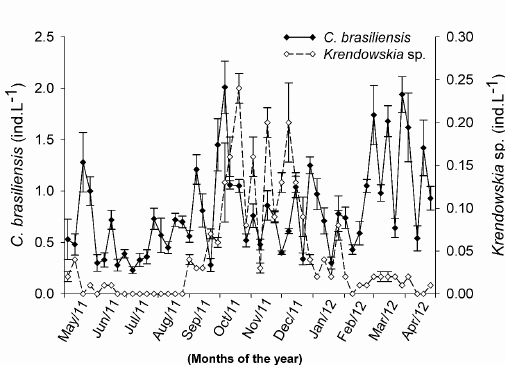
Figure 3. Weekly variation of the densities of III and IV instars of C. brasiliensis and the aquatic mite Krendowskia sp., in Lake Monte Alegre, in the period May 2011 to April 2012. Bars are standard error of the means (±) based on three replicates. Note the different scales for the species.